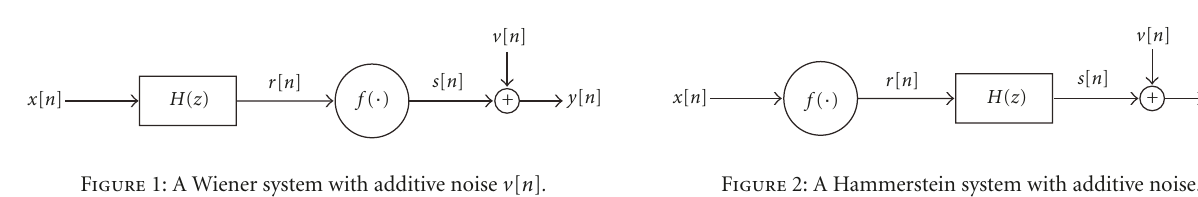
Figure 1: A Wiener system with additive noise v [ n ] . Figure 2: A Hammerstein system with additive noise.